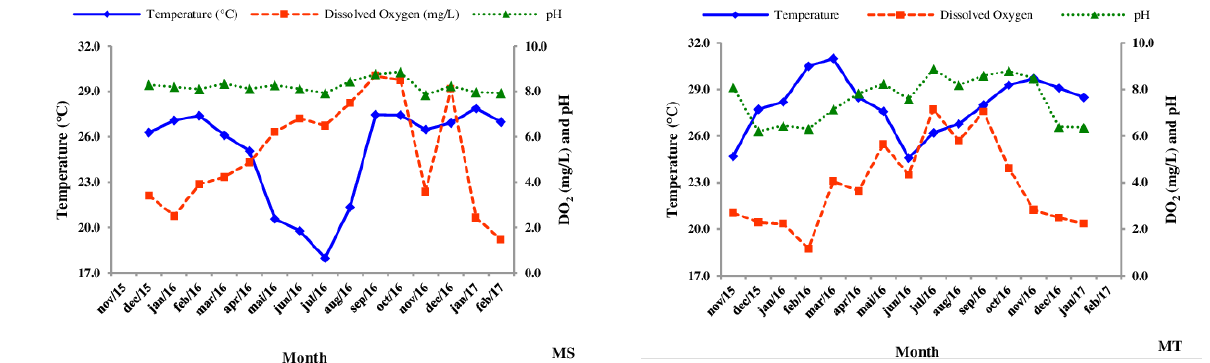
Figure 1. Mean temperature (ºC), dissolved oxygen (DO ), and pH of the water in the excavated tanks for the 2 farming of the tambaqui ( Colossoma macropomum ) families (FA and FB) from the second generation of selective breeding, cultivated for 431 days, in Santo Antônio de Leverger (MT: Mato Grosso) and Campo Grande (MS: Mato Grosso do